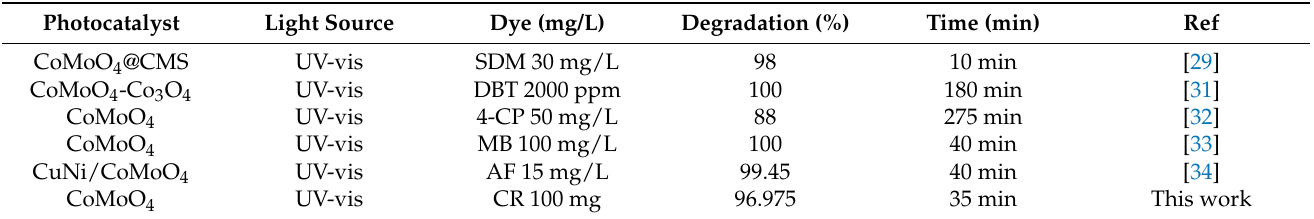
Table 1. Photocatalytic performance of the prepared CoMoO 4 in comparison with